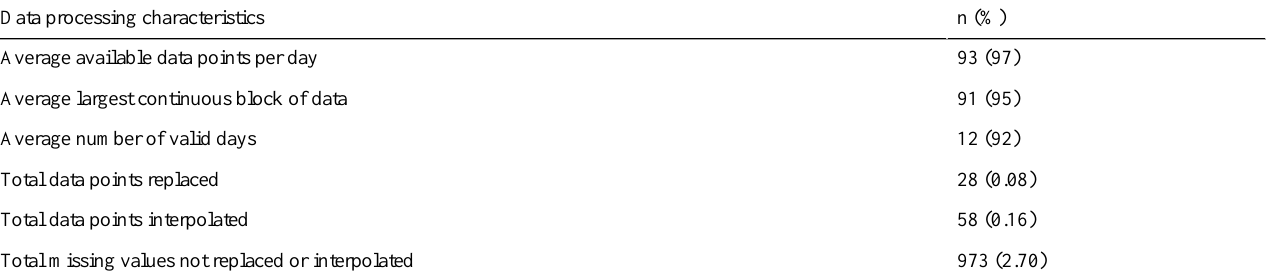
Table 2. Glucose data processing details. Due to the way the sensor was deployed, data processing information was calculated using full days only (days 2-13) and sensor information refers to the whole monitoring period. The maximum number of points per day was 96. Replaced values were taken from user scans if ±3 minutes; data points were interpolated if ≤ 2 adjacent values were missing; missing values represent data points not replaced or interpolated; if a sensor was not redeployed, data were treated as